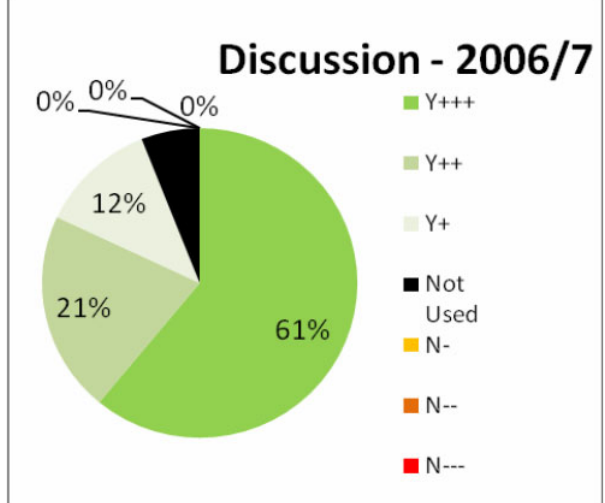
Figure 6. Discussions in 2006/7